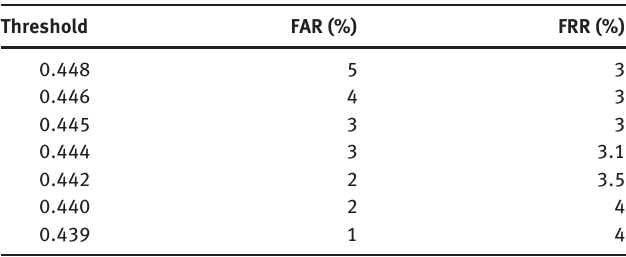
Table 3. FAR and FRR for the “CASIAV3.0” Data Set with Different Separation Points Using the Optimum Parameters and Modi- fied HD.